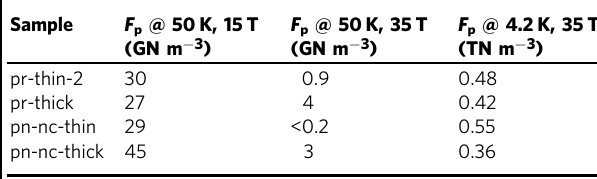
Table 2 Pinning force densities for H | | c at the temperature and magnetic fi eld conditions: [50 K,15 T], [50 K,35 T] and [4.2 K,35 T].